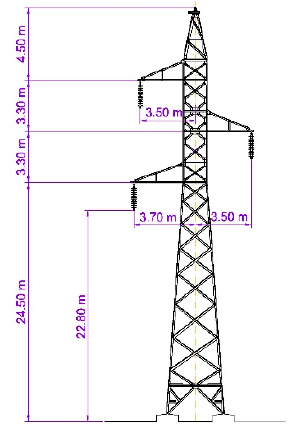
Figure 3. Modeled power system.